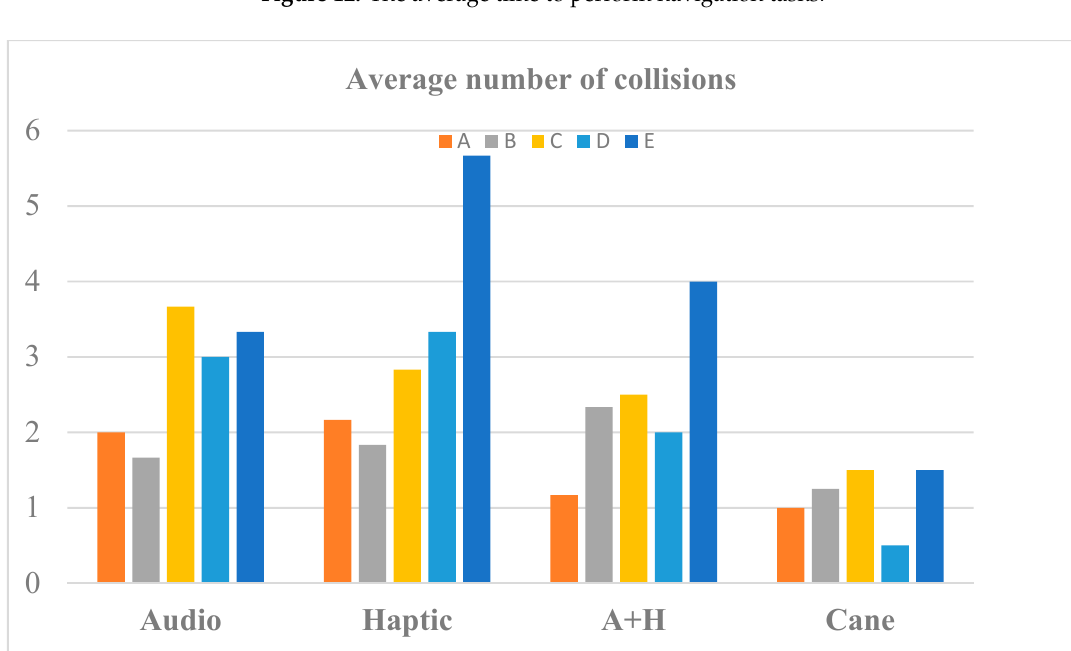
Figure 13. The average number of collisions during navigation tasks.